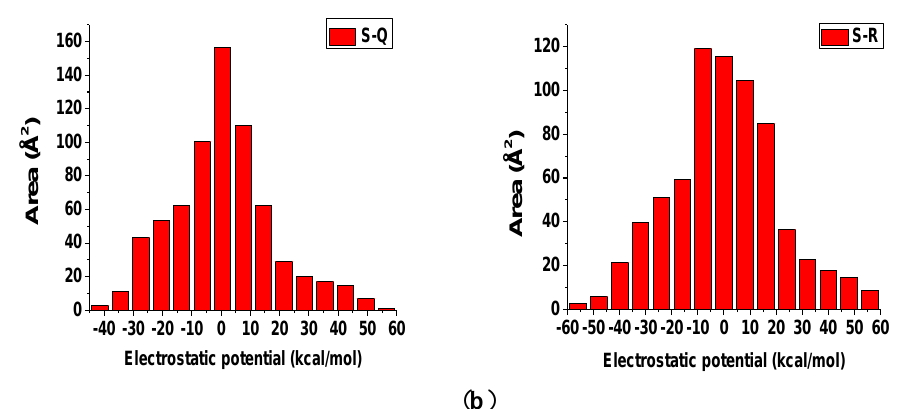
Figure 4. Electrostatic potential of S-Q and S-R.